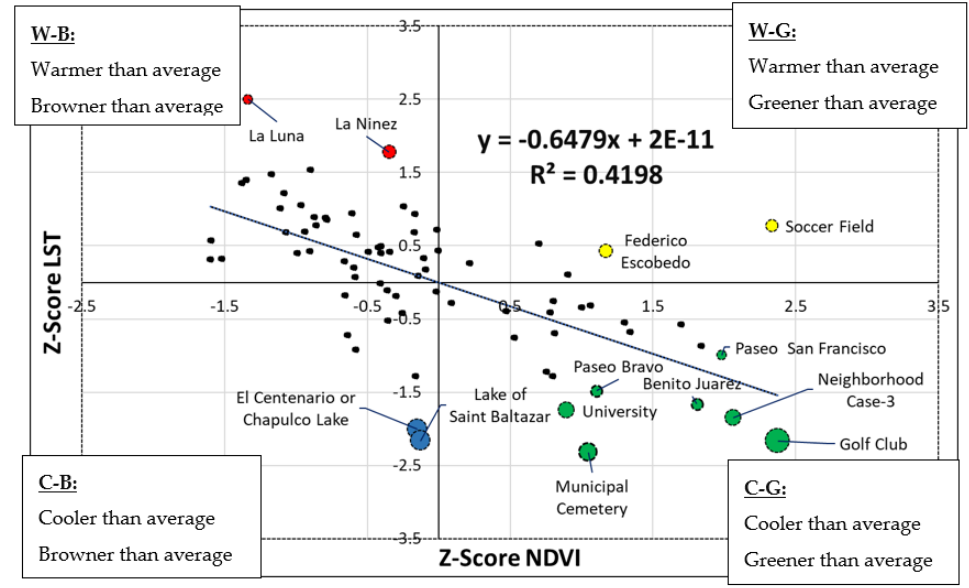
Figure 17. Relationship between NDVI z-score and the LST z-score for all 80 urban green spaces (21 May 2019). The colored circles represent the relative size of the UGS, with blue circles representing UGSs with waterbodies greater than 1 km 2 .